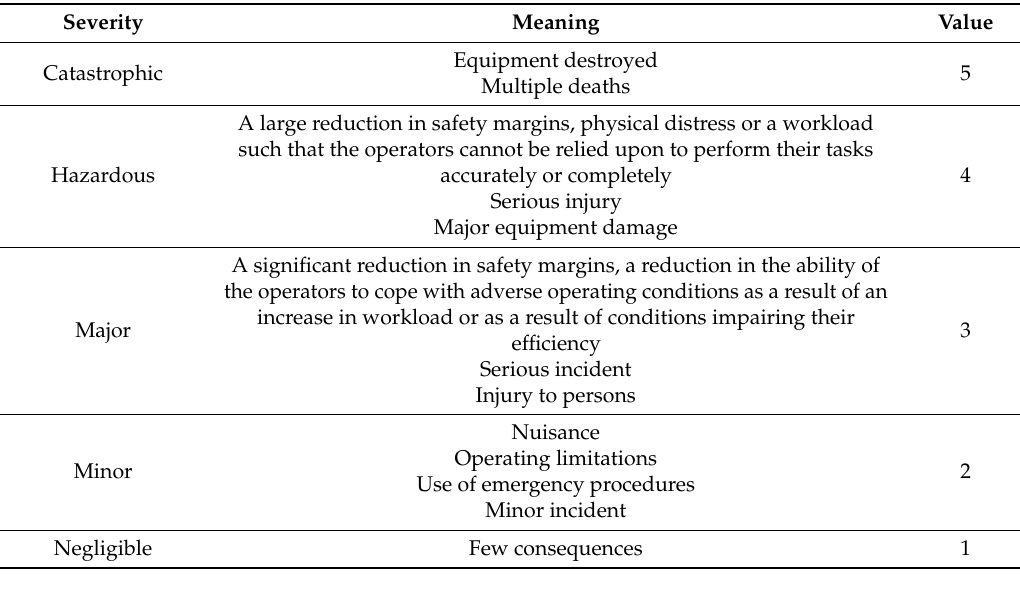
Table 4. Safety risk assessment [30].